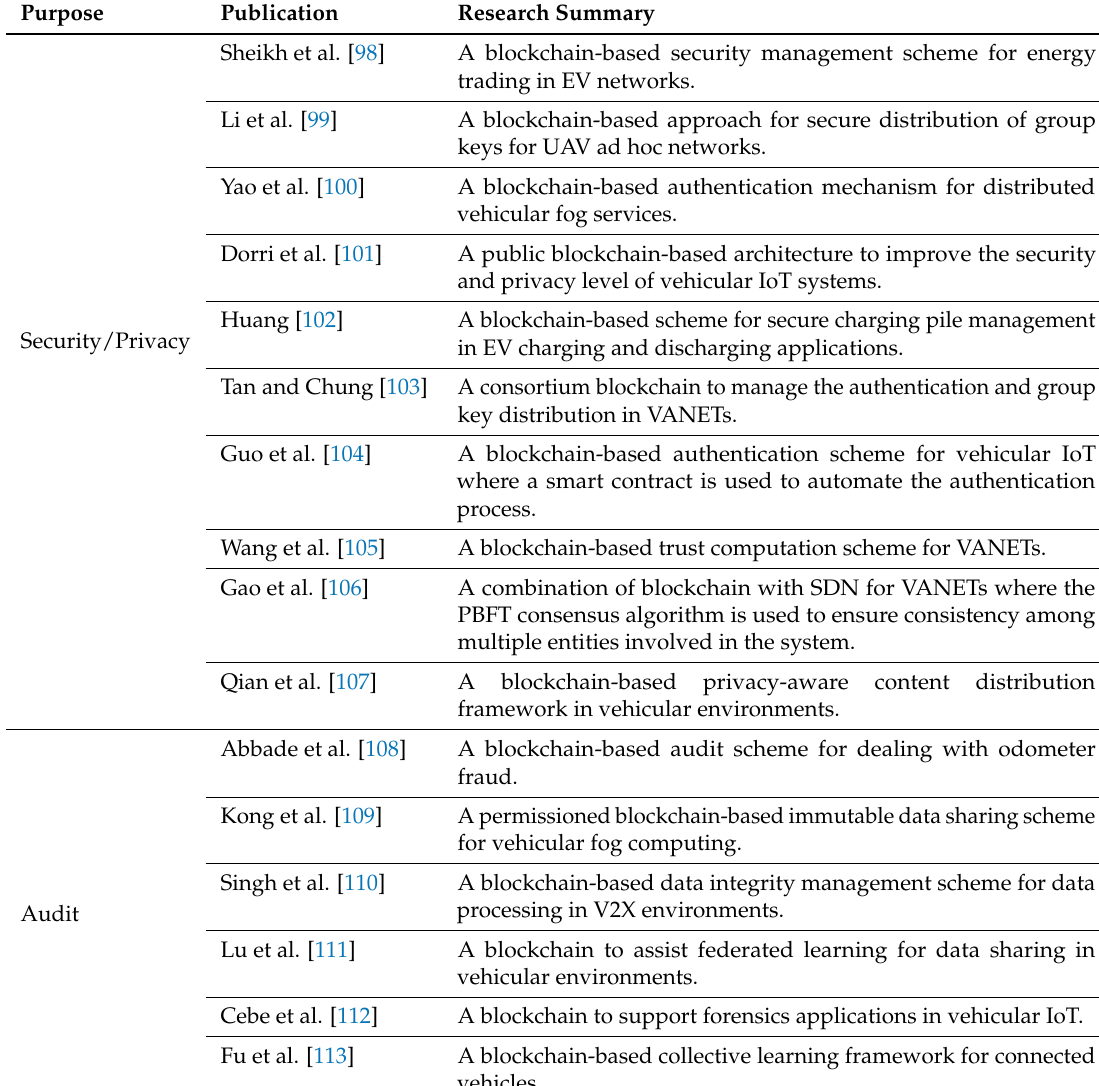
Table 5. Blockchain for application layer issues in vehicular IoT (Part